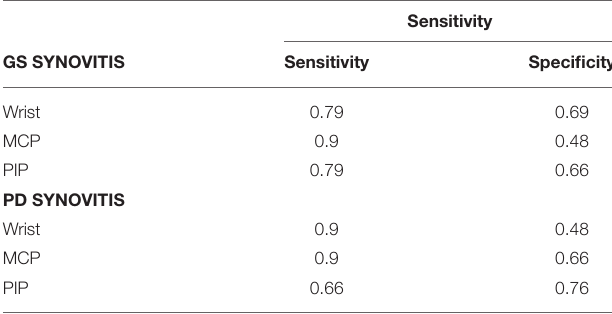
TABLE 4 | Performance of ultrasound to predict RA by elementary lesions by site.